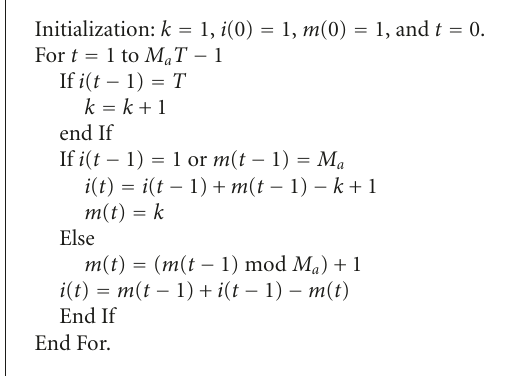
Algorithm 2: Pseudocode for determining the sequence of parallel detection of the blocks from all users in SIC.